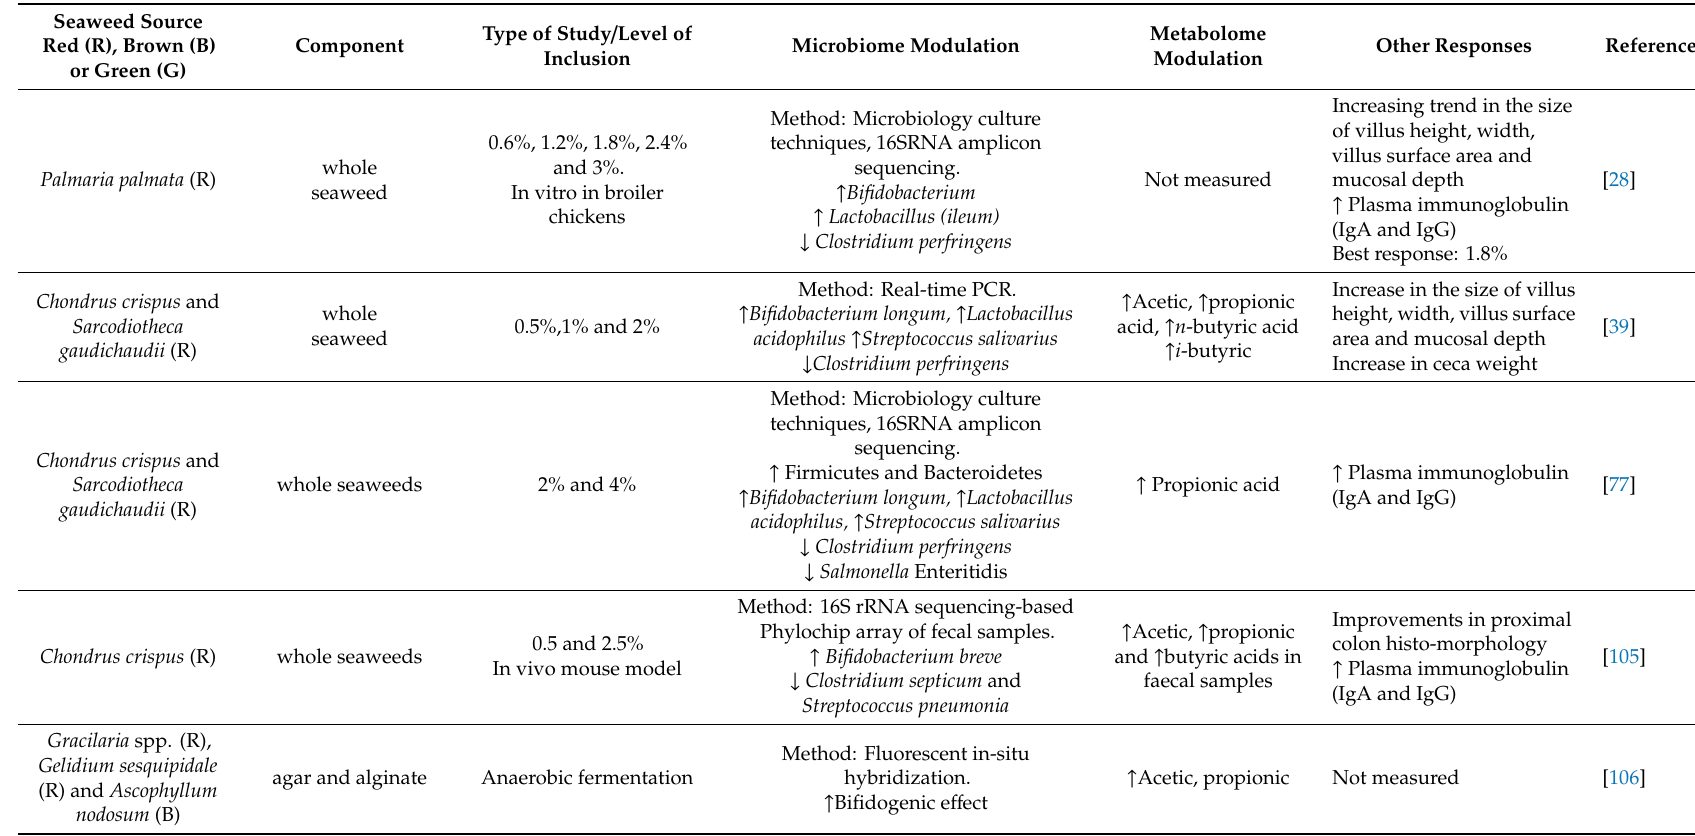
Table 2. Summary of prebiotic e ff ects of di ff erent seaweed dietary fibers (in vitro and in vivo), including modulation of the gut microbiome and fermentation response. Seaweed Source Red (R), Brown (B) or Green